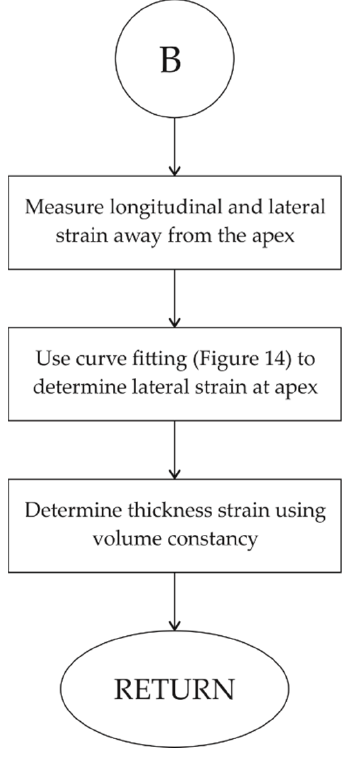
Figure A3. Apex strains for specimens with coarse necks